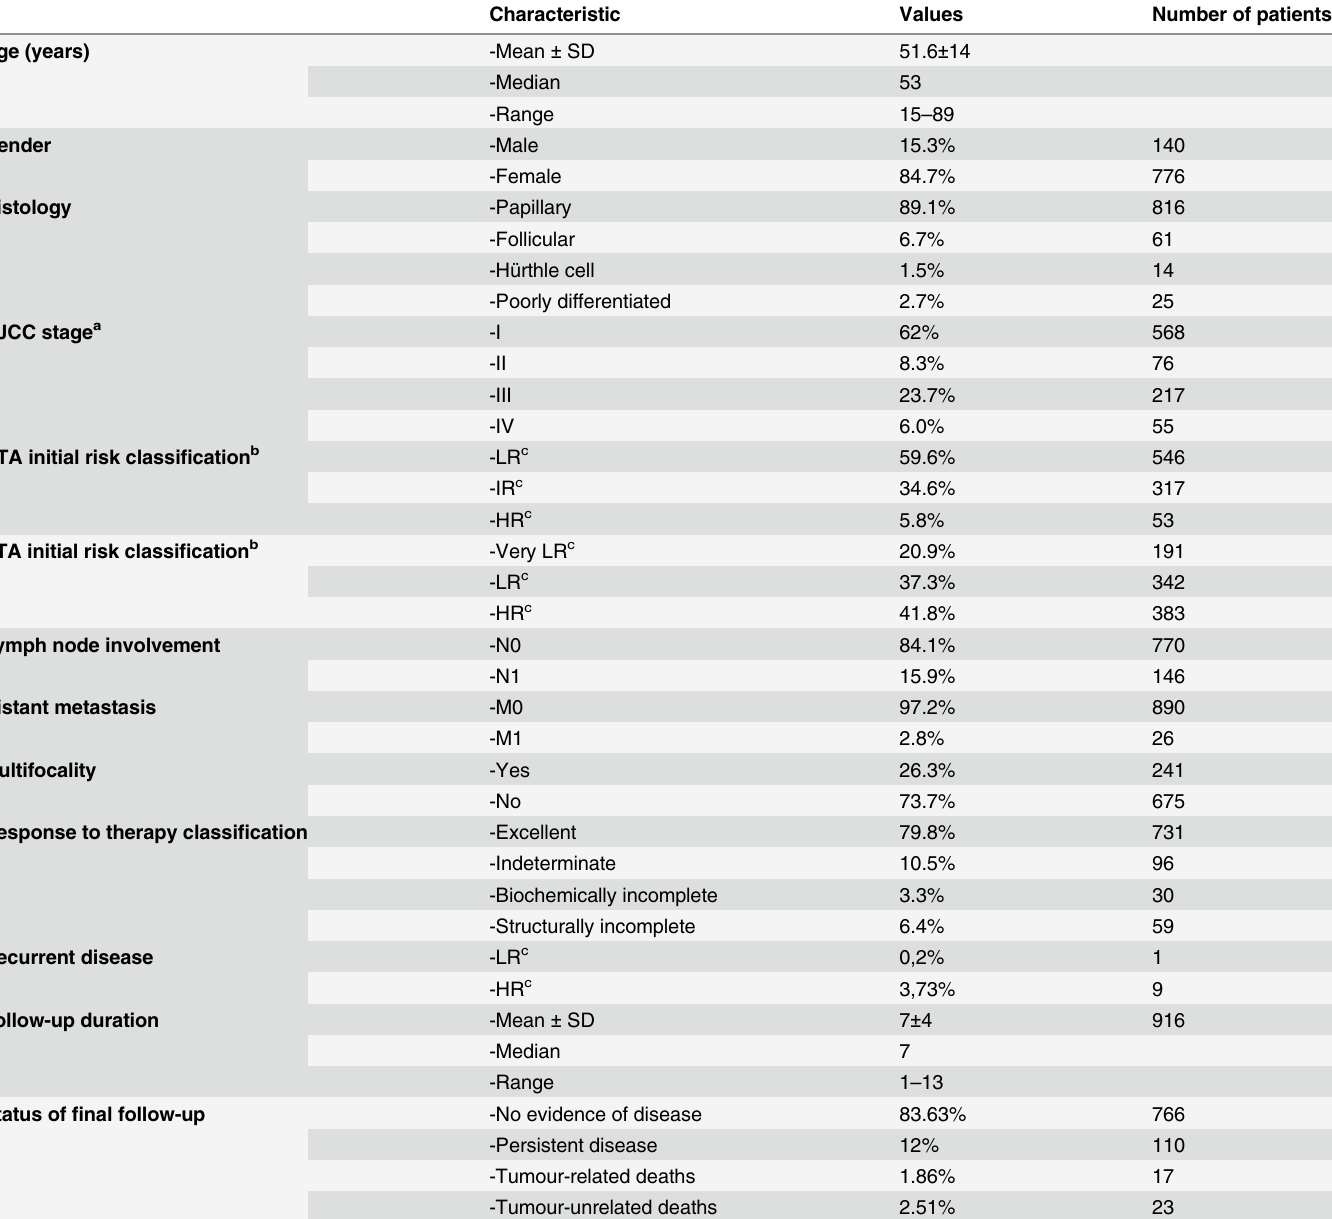
Table 1. Characteristics of the 916 differentiated thyroid cancer